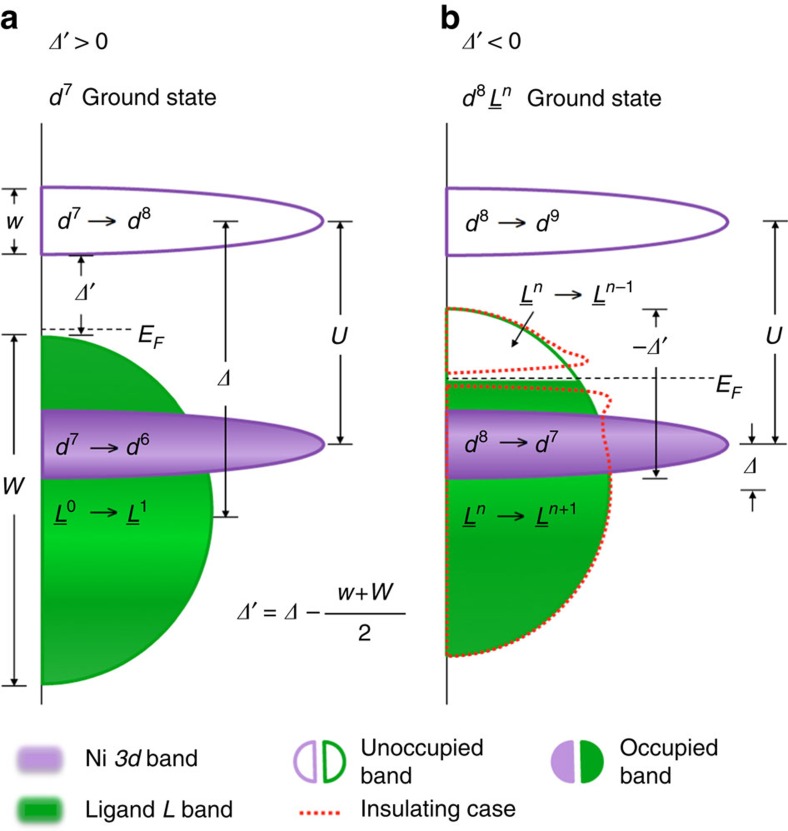
Single-electron excitation spectra in terms of charge removal and charge addition.This sketch introduces conventional parameters used to describe charge dynamics in transition metal oxide (TMO) compounds with formal 3d7 filling: (1) charge-transfer energy Δ: energy cost for transferring an electron/hole from the L band to the Ni 3d band (with respect to the band centre of mass); (2) Hubbard U: energy cost needed to remove an electron from the occupied 3d band and to add it to the unoccupied 3d band; (3) effective charge-transfer energy Δ′: key parameter to distinguish between the two different regimes discussed here. Δ′ is defined by the equation in the figure, starting from Δ. This figure identifies the ground state (GS) and the gap character obtained for two Δ′ regimes: (a) Δ′>0. In conventional positive charge-transfer compounds the lowest energy removal states are ligand based, and the lowest energy addition states are transition metal based, leading to a charge-transfer derived energy gap (O 2p–Ni 3d like) and a 3d7 GS. (b) Δ′<0. In negative charge-transfer compounds, one hole per Ni is doped into the ligand band, giving a density of ligand holes n, Ln. The GS is here Ni 3d8Ln. The red-dashed contour bands are a cartoon-like demonstration of the opening of the gap in the mainly O 2p continuum resulting in the metal to insulator transition. In this case, the lowest energy removal and addition states are both ligand based, leading to an O 2p–O 2p like gap. Under no circumstances can this type of gap result from configuration a, unless active doping is considered. Note that this figure neglects Ni–O hybridization, to provide clear distinction between the regimes.